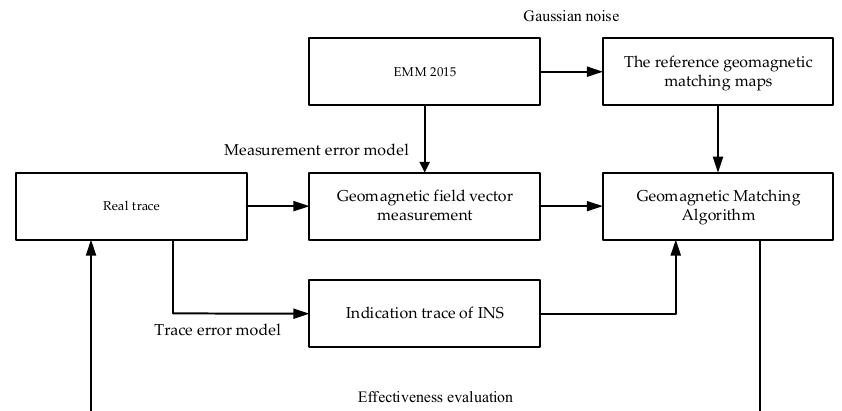
Figure 2. The simulation flow of geomagnetic matching navigation. Table 2. Simulation condition of INS. Table 1. The parameters of simulation.